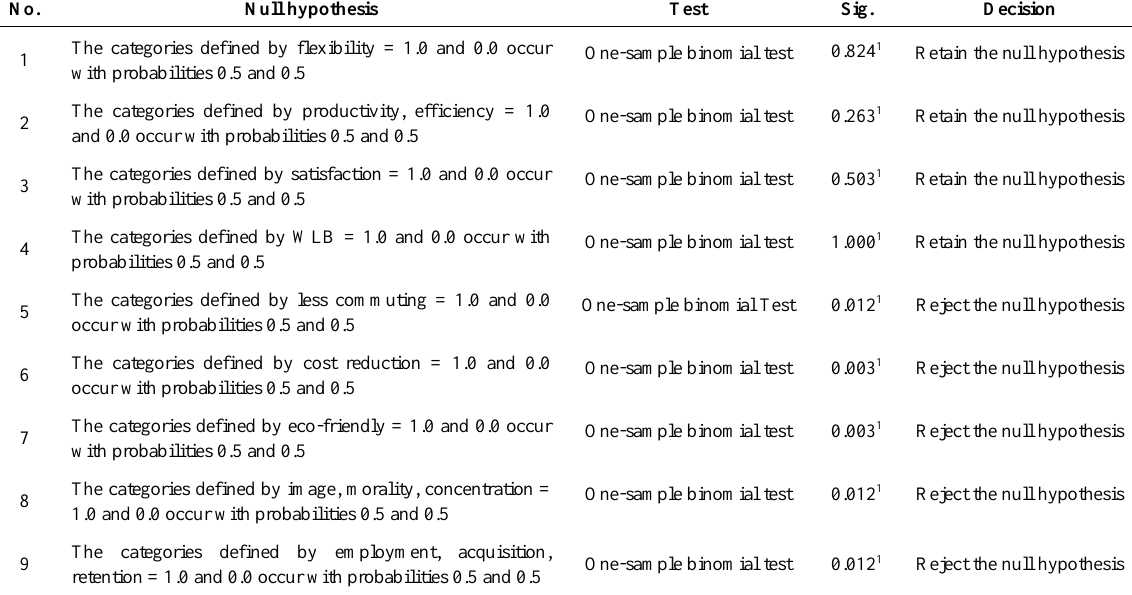
Table 6. Hypothesis test